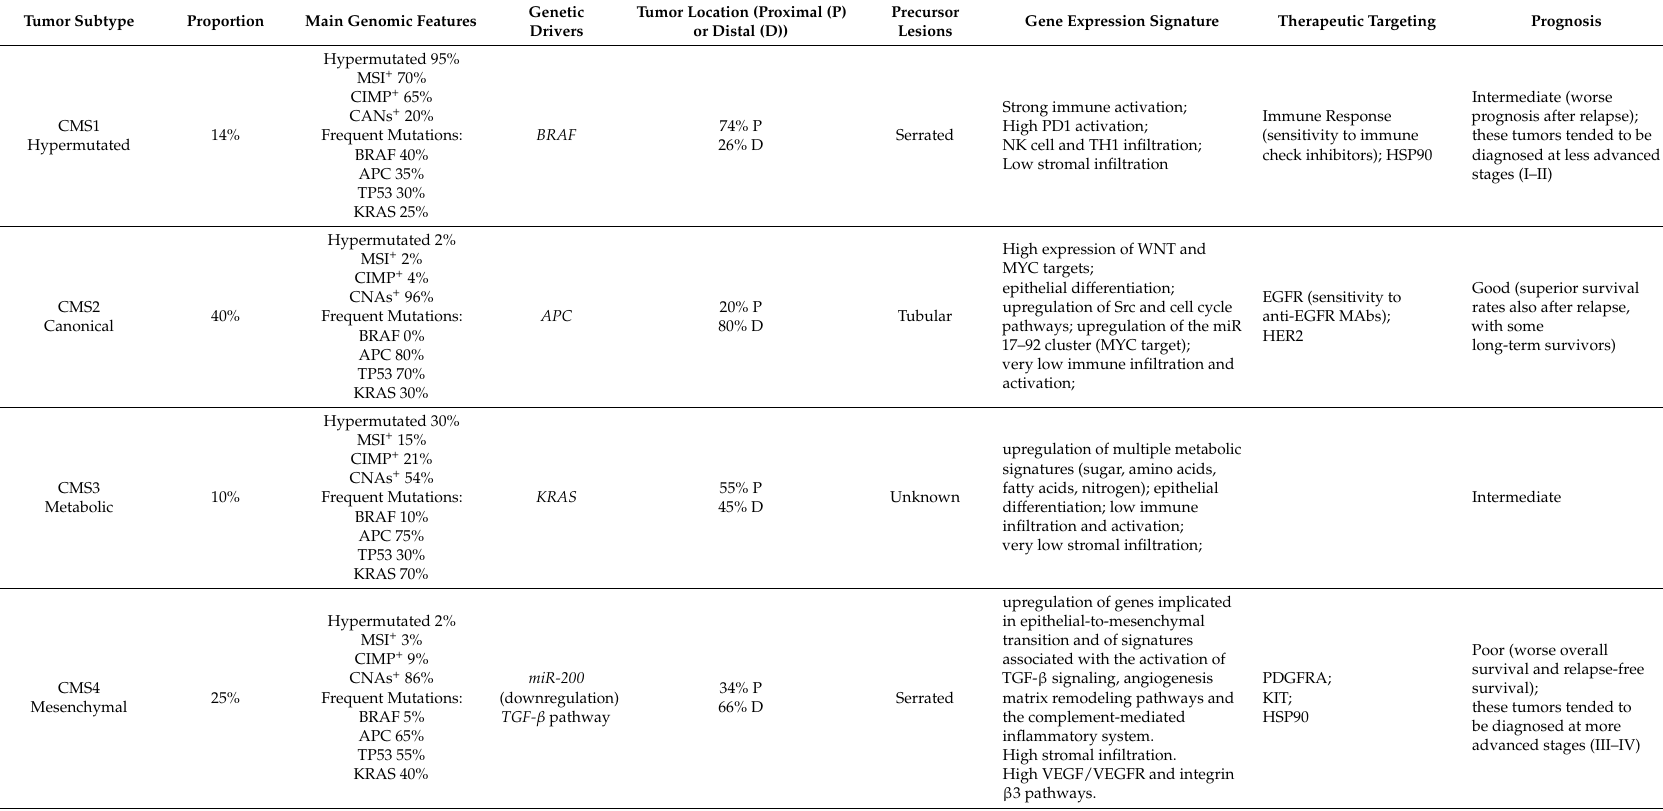
Table 2. The gene expression-based consensus molecular subtypes (CMS) of colorectal